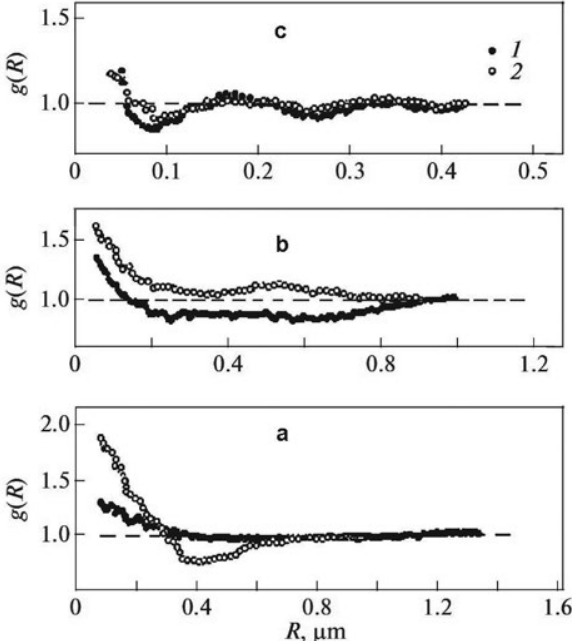
Figure 3. Distribution functions g(R) of the clusters density along the directions: solid phase (1) and porous phase (2) for λ = 24 (a), 36 (b) and 69 (c).